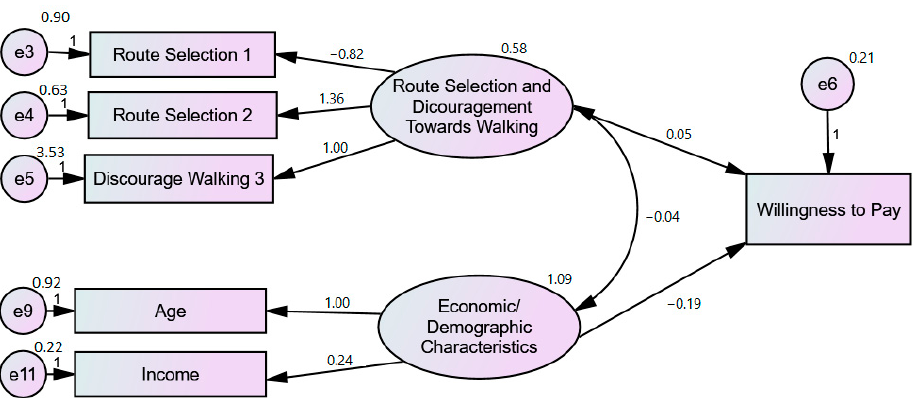
Figure 2. Diagram of the SEM Reflective Model.